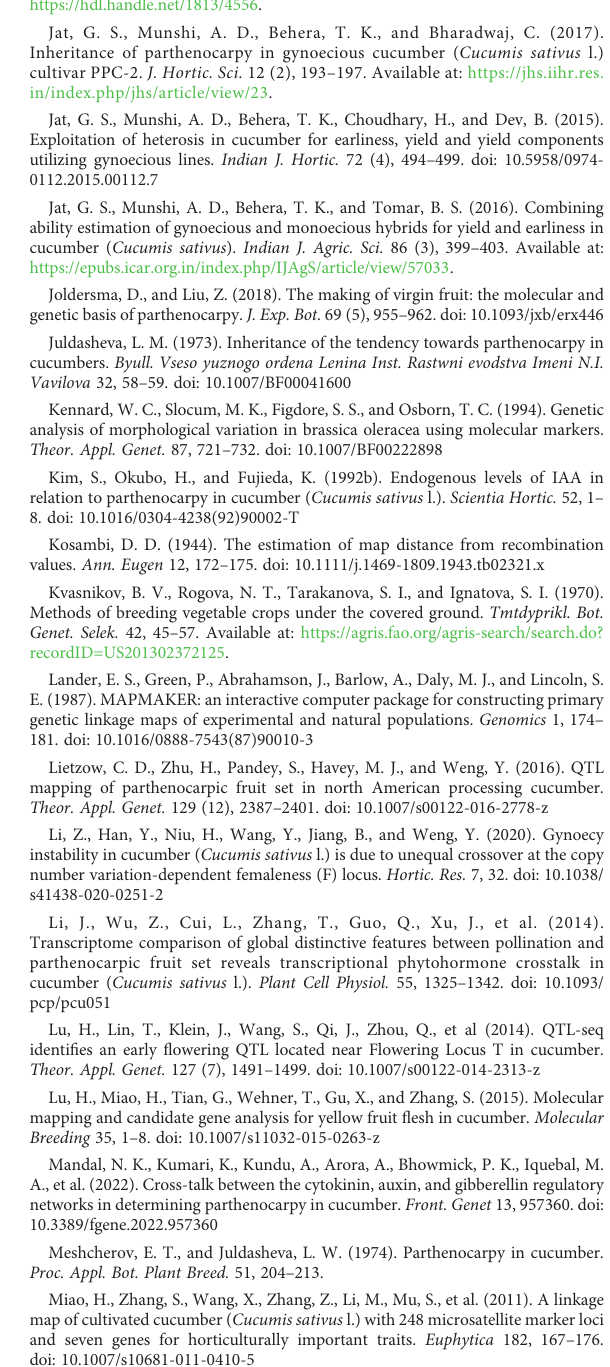
SUPPLEMENTARY TABLE 3 List of the polymorphic markers used for construction of linkage map and molecular mapping of parthenocarpy using F2:3 population. chromosome 3 and